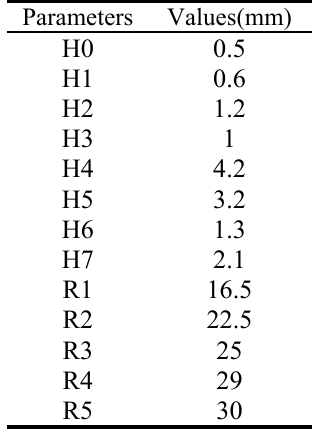
Fig. 5. Dimensional parameters of the stator and the